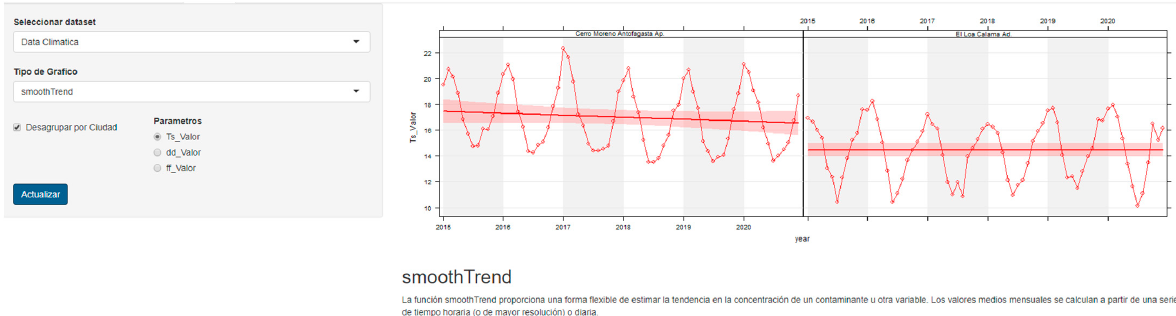
Figure A8. Temperature time series plot for the meteorological stations of Cerro Moreno Antofa- gasta Ap. And El Loa Calama Ad. between the years 2015 and 2020. Generated with the option “ smootTrend ”. The “timeVariation” option can also be used on the parameters of the DMC meteoro- logical stations. Figure A9 shows the time series generated with this option for the com- bined meteorological stations of the Antofagasta Region between 2015 and 2020.